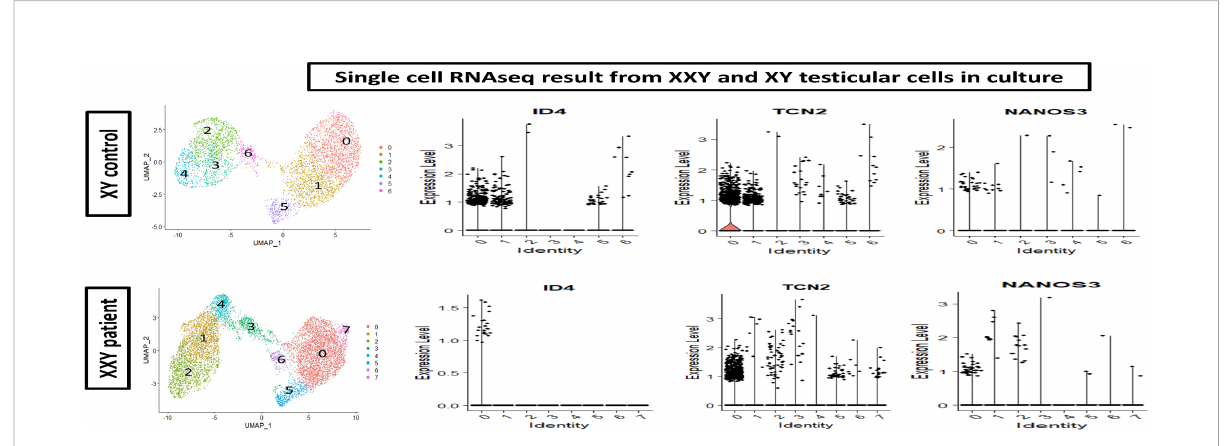
FIGURE 7 Single cell RNAseq analysis of cultured human XY (upper panel) and XXY (lower panel) testicular cells. Cell partitioning via UMAP identi fi ed 6 clusters in cultured XY and 7 clusters in cultured XXY testicular cells. Expression patterns of ID4, TCN2 and NANOS 3 (violin plot) supported the presence of SSCs during the culture.